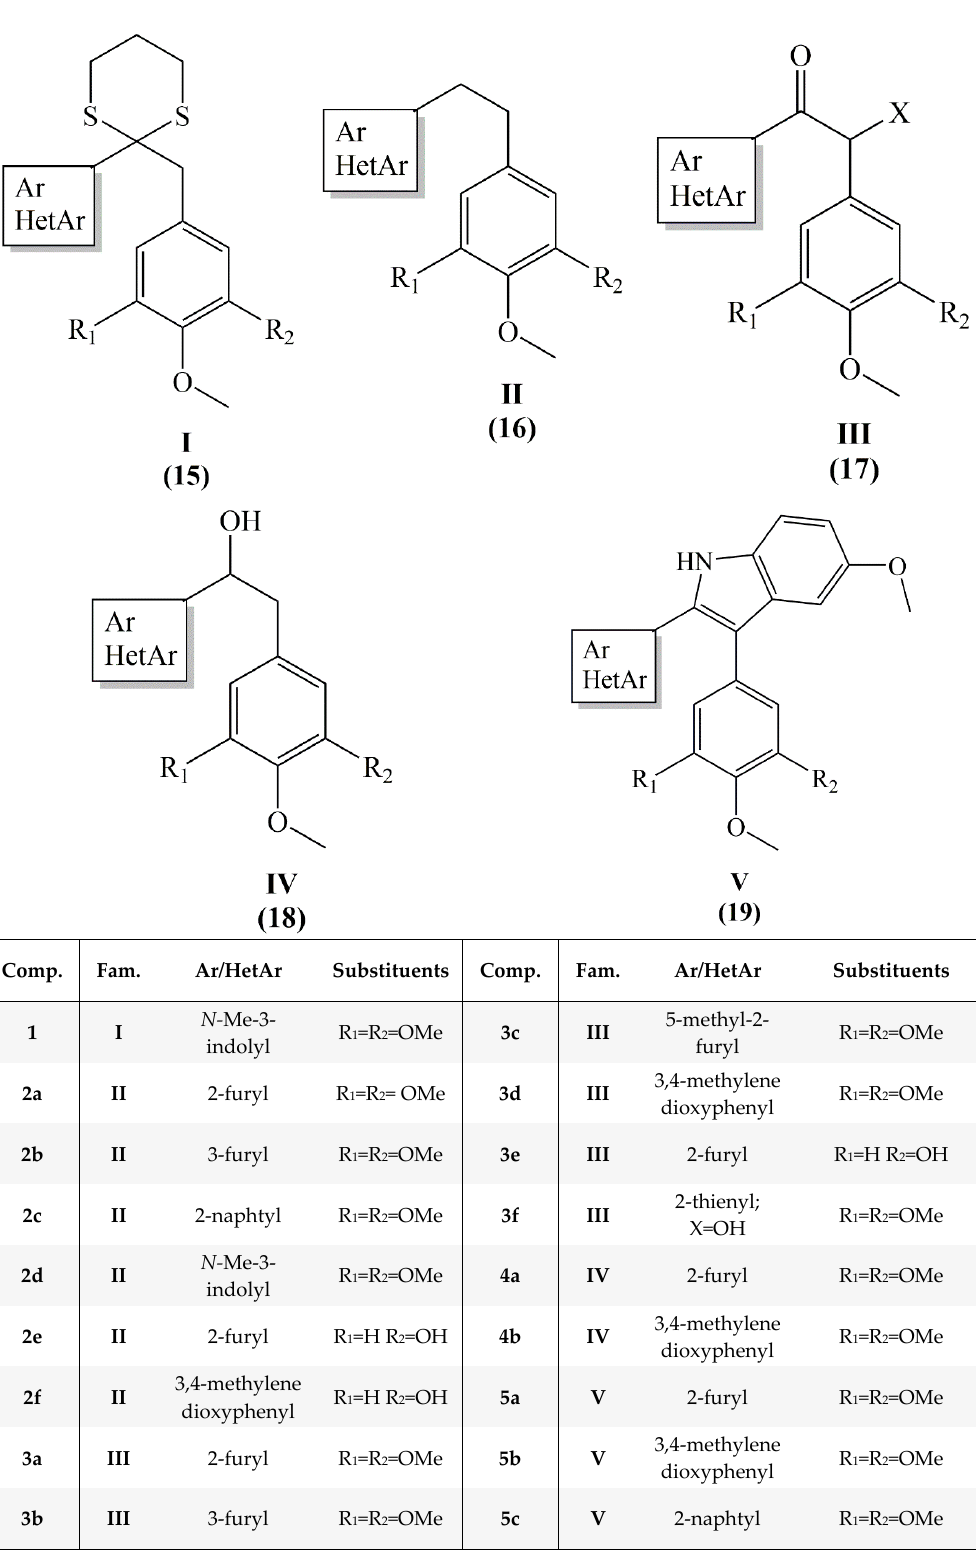
Figure 7. Structure of dithianes (Series I), ethane (series II), ethanones (series III), ethanol (series IV) and indole (series V) derivatives of combretastatin.